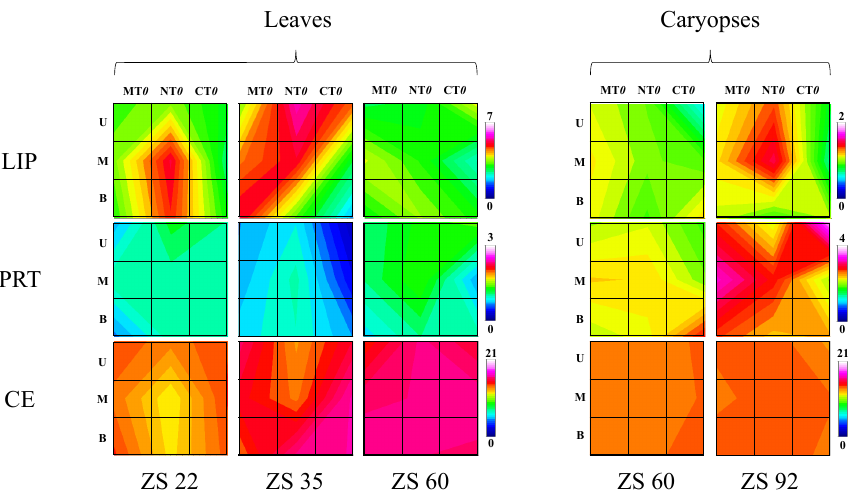
Figure 6. IR maps representing the biochemical composition of durum wheat leaves and caryopses, in terms of lipids (LIP maps), proteins (PRT maps) and cellulose (CE maps) in relation with the topography of the cultivated areas and in relation with sampling times. Each square represents the ground arrangements according to Figure 1B (see Materials and Methods). The chromatic scales used for leaves and caryopses goes from blue (low content) to red/pink (high content); ranges are indicated on the right side of each square. Tillage methods are indicated with CT 0 (conventional tillage), MT 0 (minimum tillage) and NT 0 (no tillage); no nitrogen fertilization was applied. Sampling times were ZS 22, ZS 35 and ZS 60 for leaves, and ZS 60 and ZS 92 for caryopses. The letters on the left belong to the land position: up (U); mid (M) and bottom (B).